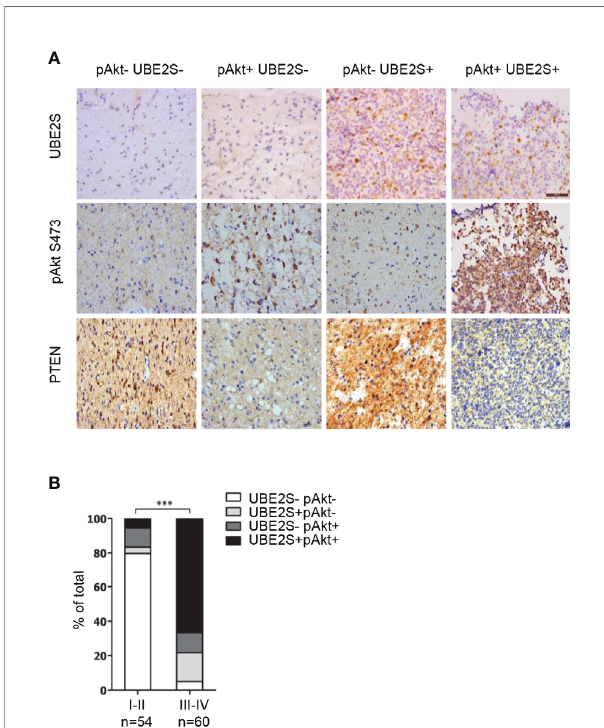
FIGURE 5 | Association of UBE2S expression and activation of Akt pathway in glioma clinical samples. (A) Representative IHC staining for UBE2S, pAkt and PTEN on adjacent sections of formalin- fi xed paraf fi n-embedded human glioma specimens. Scale bar: 50 m m. (B) Summary of the IHC assessment of